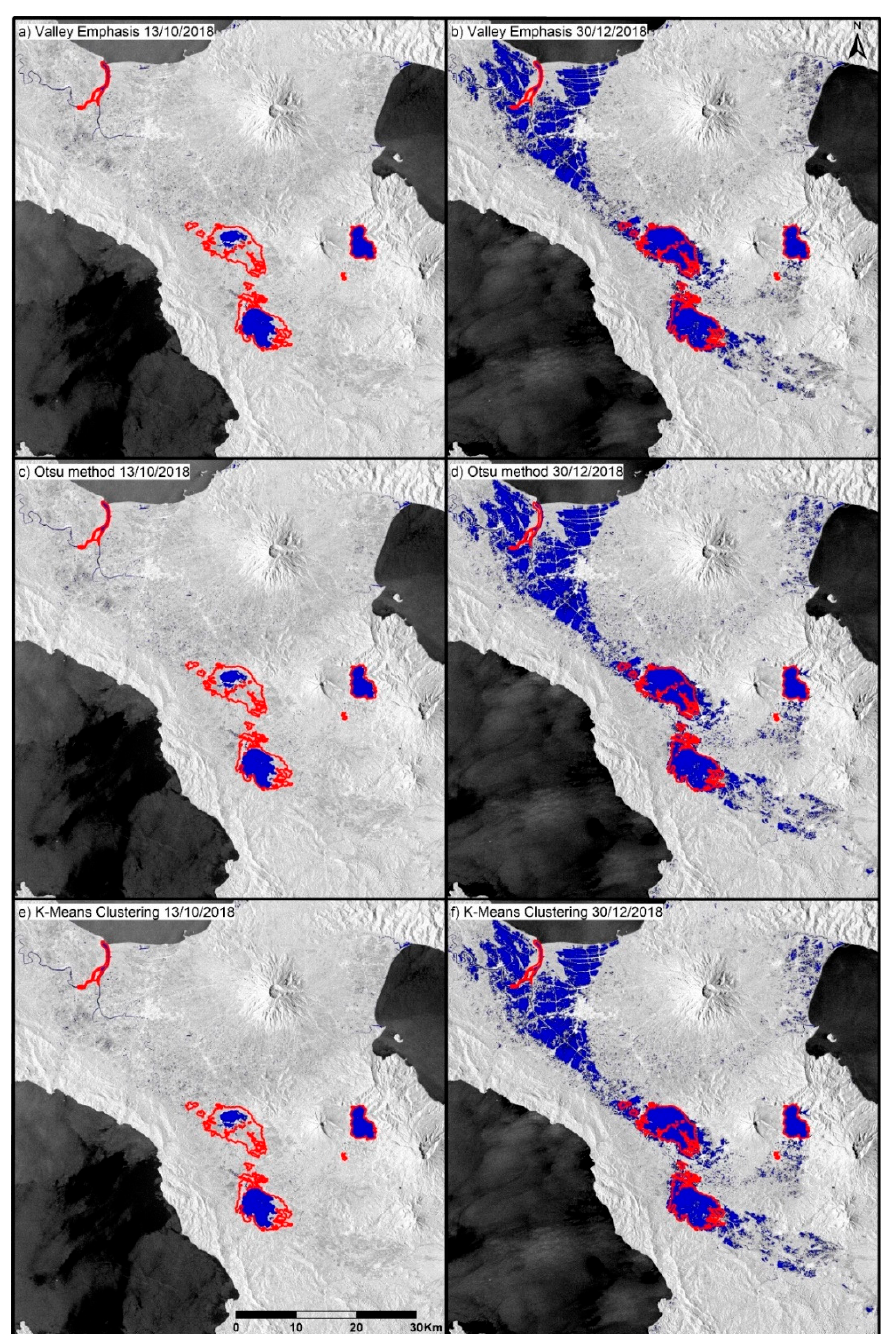
Figure 5. Examples of results in terms of open water extent obtained by multiple methods. Blue areas represent the extracted open water features, and red polygons represent SWBD water body boundaries. ( a,c,e ) represent the extent of open water features before the rainfall events responsible for the flooding. ( b,d,f ) represent the extent of open water features after the first flood pulse (main).